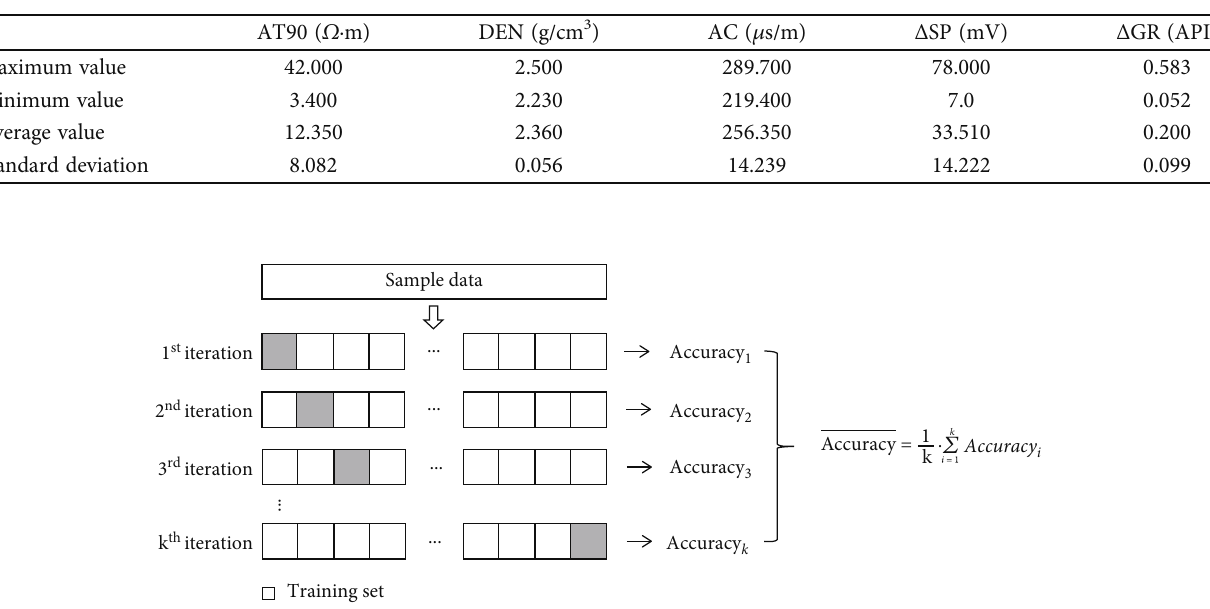
Table 4: The statistical information of the input data for building the